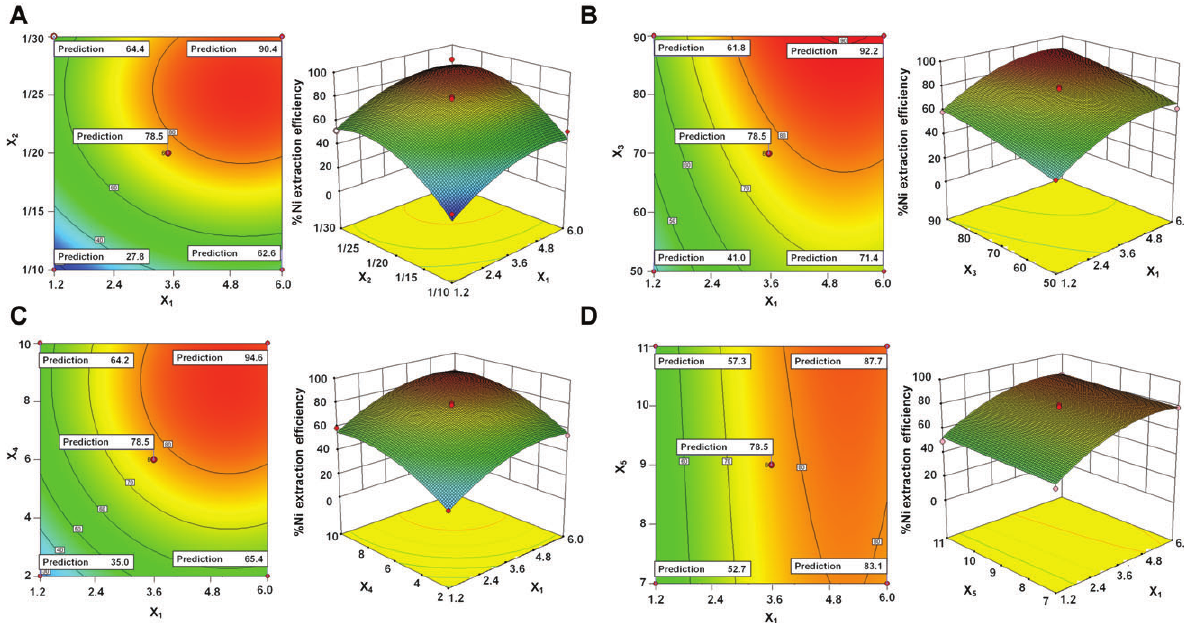
Figure 4 ( A) Mutual effect of MR (X ) and S/L (X ) on (%) Ni extraction using (S,S)-ethylenediamine disuccinic acid { [S,S]-EDDS } , ( B) mutual 1 2 effect of MR (X ) and temperature (X ) on (%) Ni extraction using [S,S]-EDDS, (C) mutual effect of MR (X 1 3 extraction using [S,S]-EDDS and (D) mutual effect of MR (X ) and reaction pH (X ) on (%) Ni extraction using 1 5